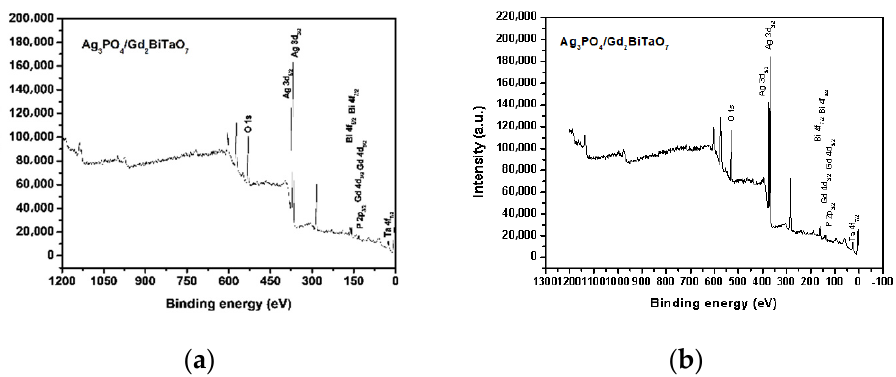
Figure 21. ( a ) XPS survey spectrum of the Ag 3 PO 4 /Gd 2 BiTaO 7 heterojunction photocatalyst before the reaction of photocatalytic degradation of bisphenol A; ( b ) XPS survey spectrum of the Ag 3 PO 4 /Gd 2 BiTaO 7 heterojunction photocatalyst after the reaction of photocatalytic degradation of bisphenol A.